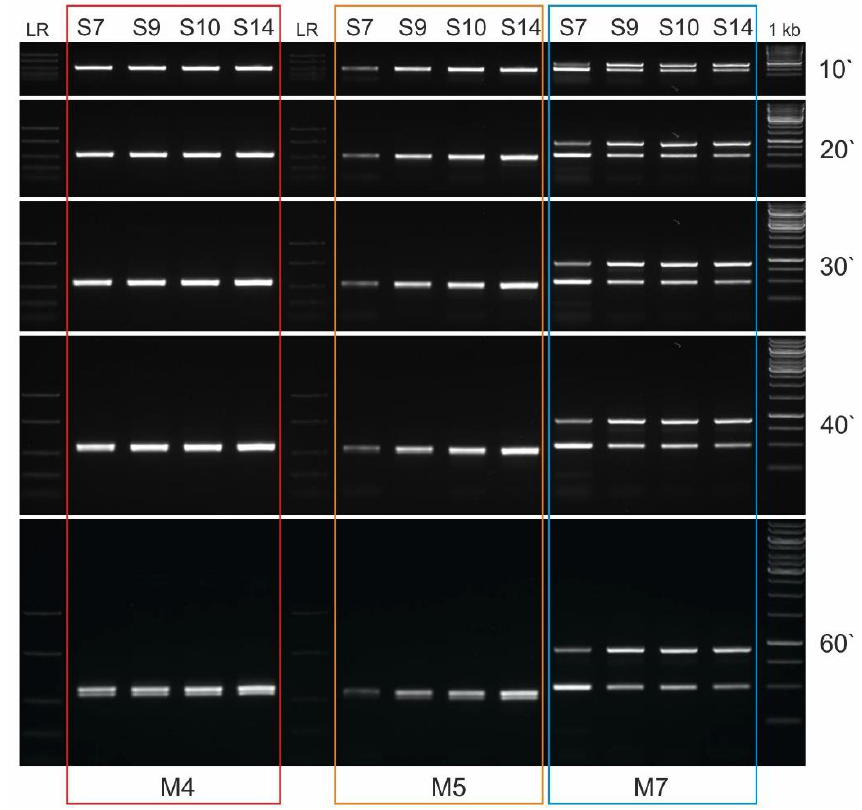
Figure 6. Patterns of the PCR products representing M4, M5 and M7 markers obtained for female individual of four turaco species (S7, S9, S10, and S14, see Table 1). The image shows the separation of amplicons in a 1% agarose gel after 10, 20, 30, 40 and 60 min of electrophoresis. Lane 1 kb—GeneRuler 1 kb DNA Ladder (Thermo Scientific). Lane LR—FastRuler Low Range DNA Ladder (Thermo Scientific).